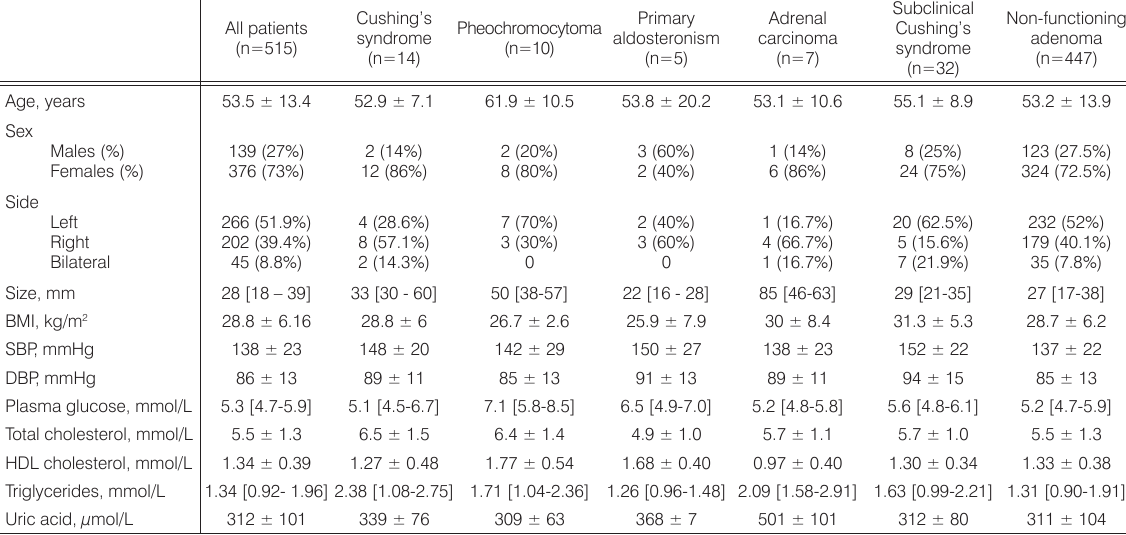
Table 1. Demographic and clinical characteristics of patients with different types of incidentally found adrenal tumours.